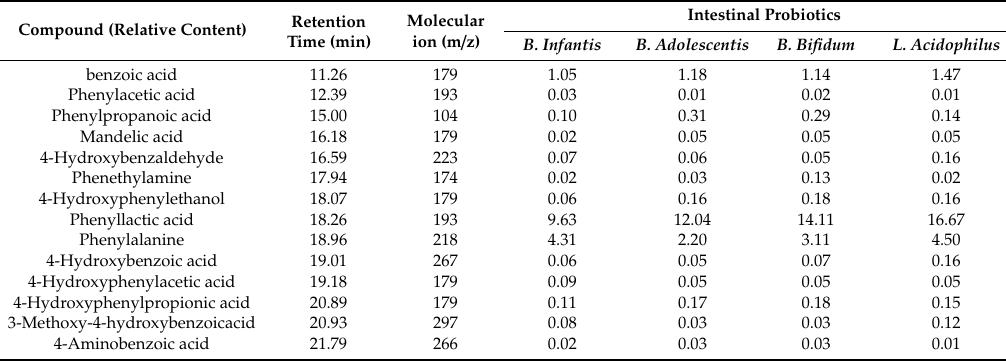
Table 4. Relative content of Cy3glc-C12 metabolites produced by Bifidobacteria and Lactobacilli at 24 h of incubation under anaerobic conditions at 37 ◦